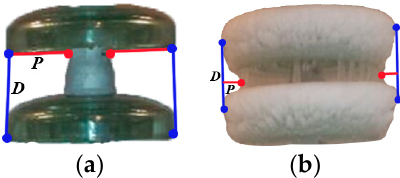
Figure 6. The change of graphical shed spacing ( D ) and graphical shed overhang ( P ), ( a ) before icing, ( b ) after icing.